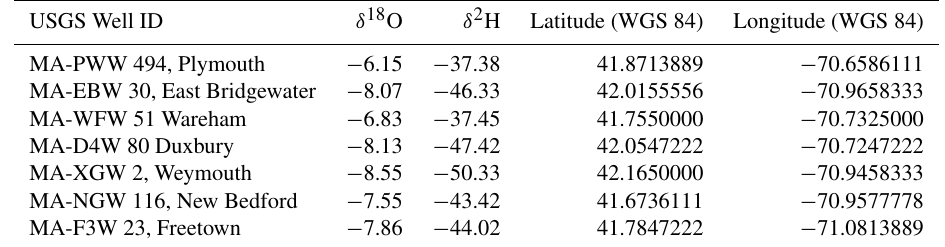
Table 1. USGS groundwater wells δ 2H-H 2 O and δ 18O-H 2 O isotopic data used to establish the regional groundwater